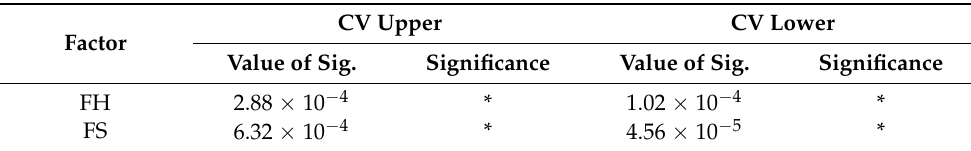
Table 7. Variance analysis of CV of droplet coverage density. CV Upper CV Lower Factor Value of Sig. Value of